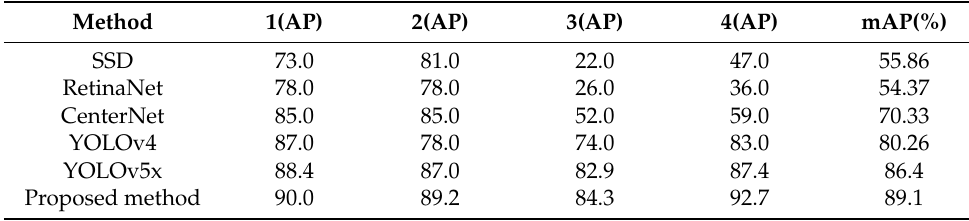
Table 7. Detection results for some mainstream object detection